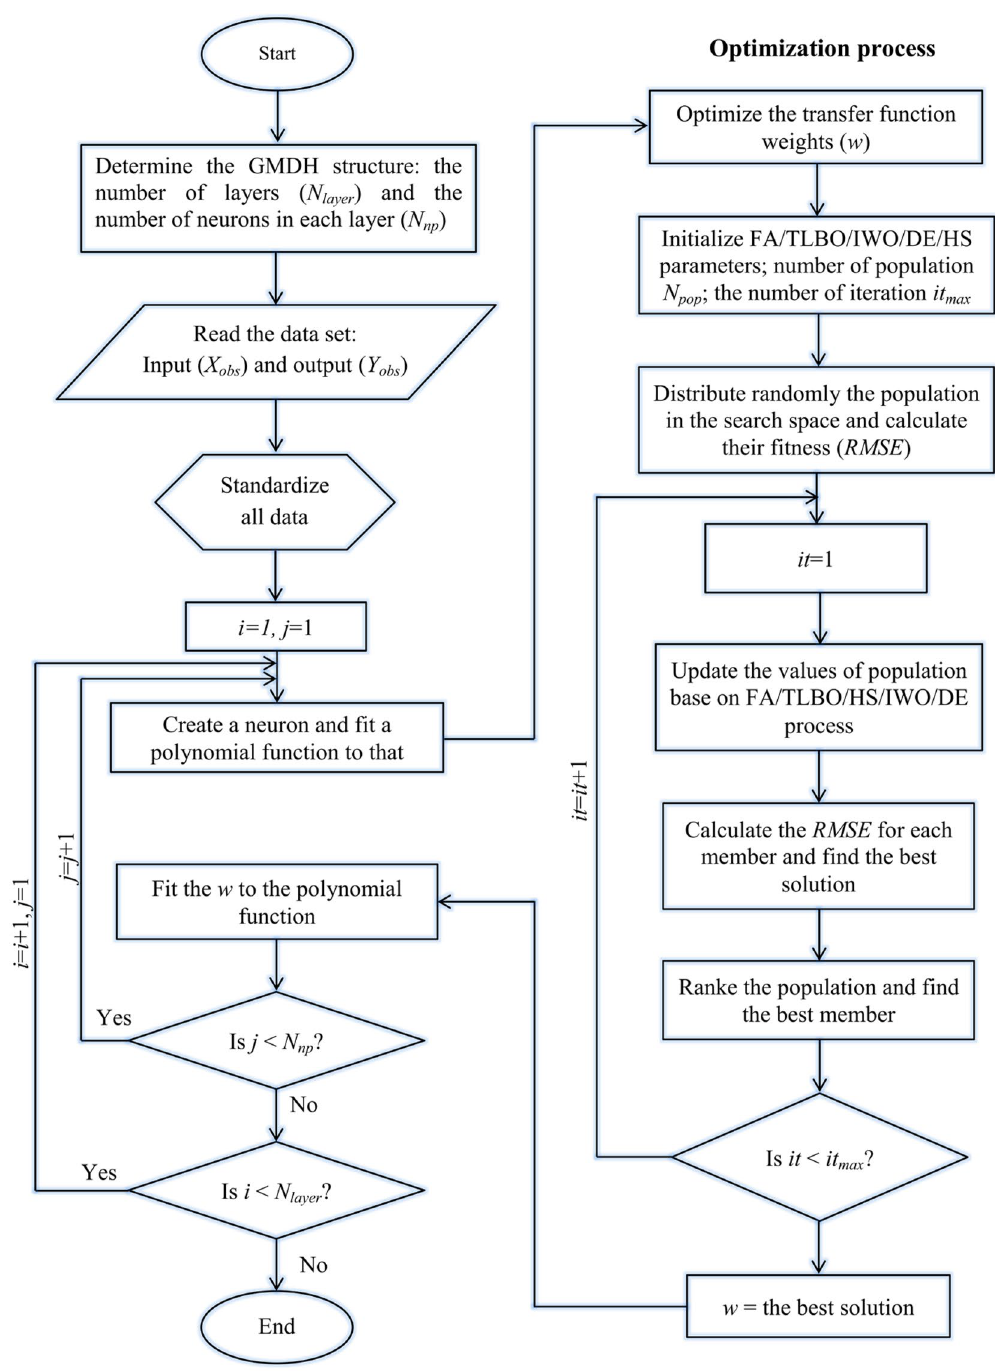
Figure 3. The general flowchart of the constructed hybrid GMDH